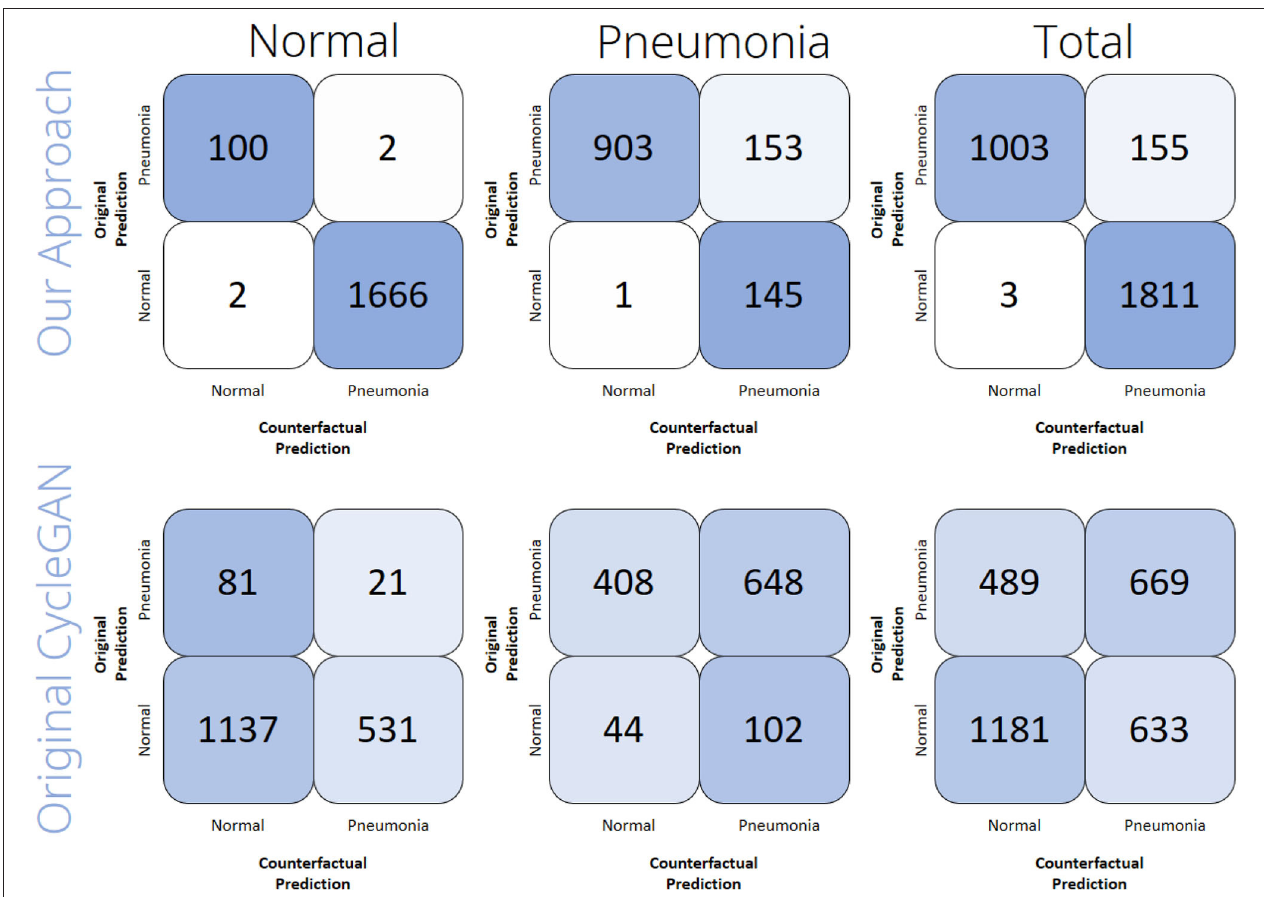
FIGURE 4 | Computational evaluation results of the counterfactual image generation performance. The confusion matrices show the number of samples out of each subset (Normal, Pneumonia, Total) of the rsna dataset that the classifier predicted to be the respective class before (y-axis) and after (x-axis) the samples had been translated by either the original CycleGAN or by our